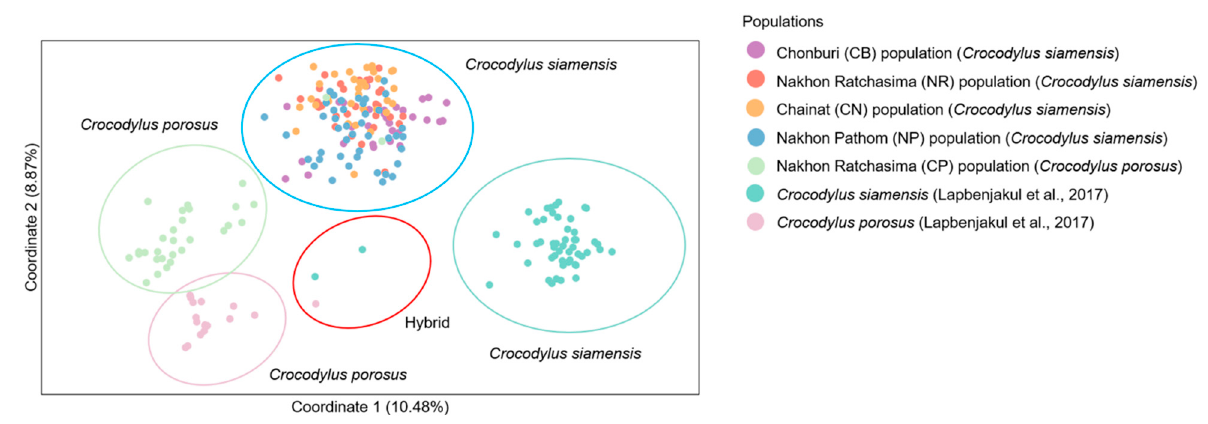
Figure 2. Principal component analysis of Siamese ( Crocodylus siamensis , Schneider, 1801) [1] and saltwater crocodiles ( C. porosus , Schneider, 1801) [13]. Table S1 provides detailed information on the sampled individuals and Lapbenjakul et al. [11].